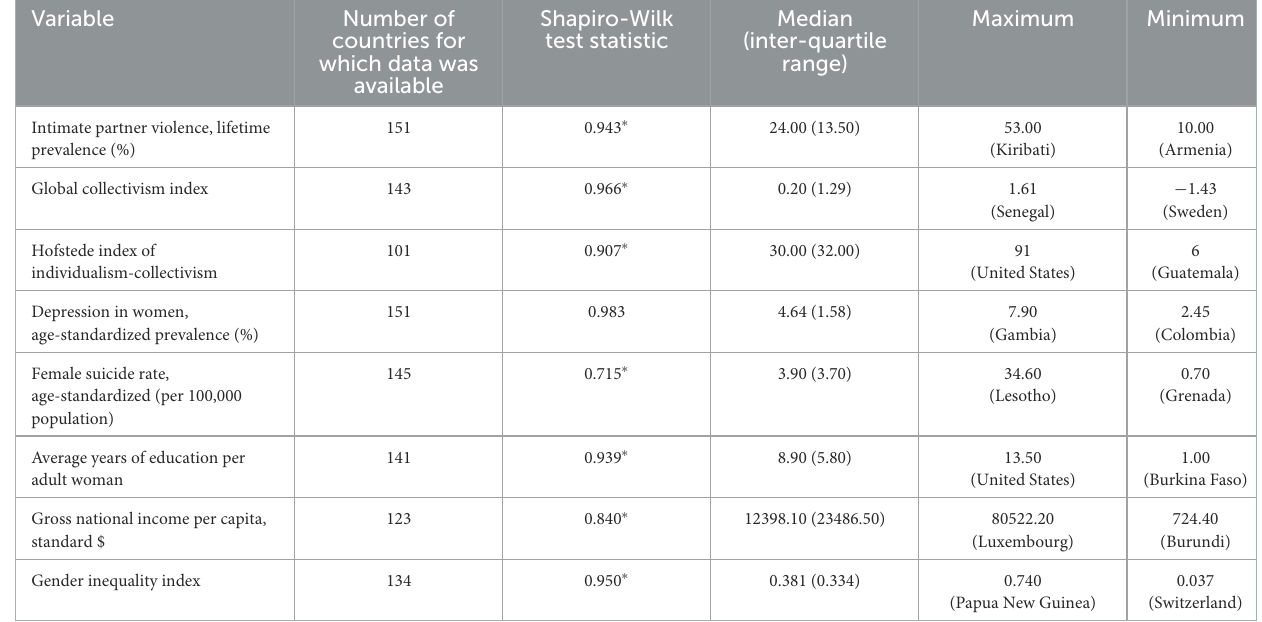
TABLE 1 Descriptive statistics for all variables analyzed in the current study. Variable Number of countries